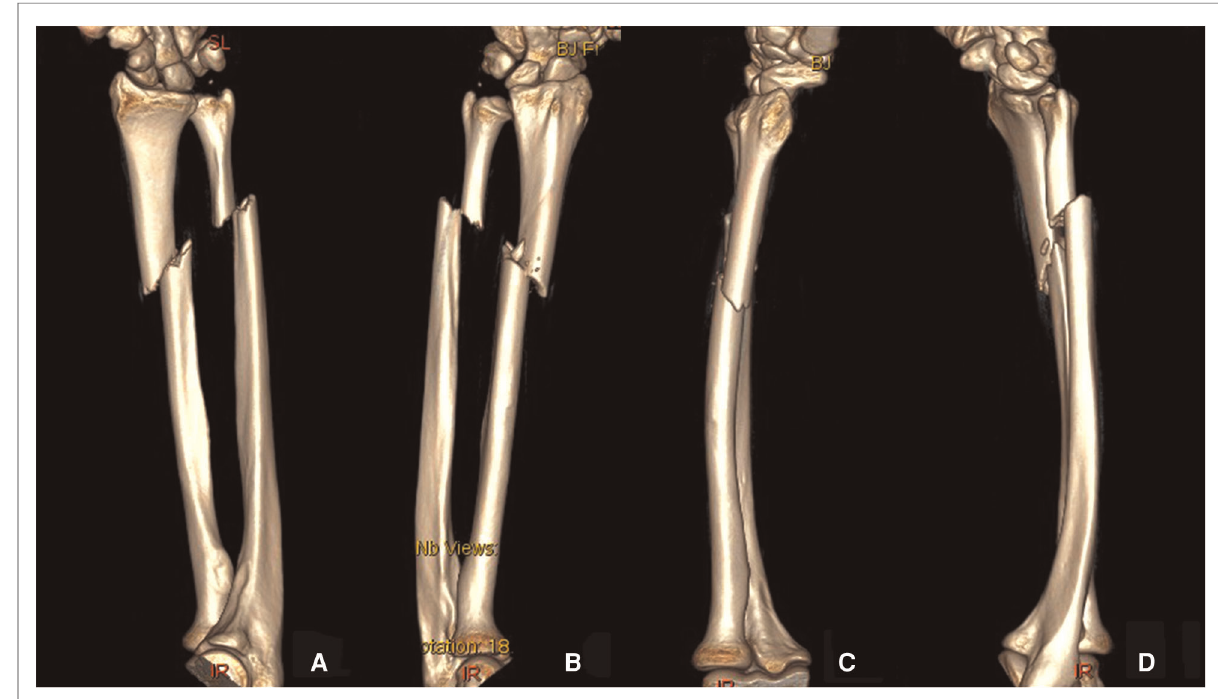
FIGURE 2 Preoperative three-dimensional reconstructive CT images ( A – D ) of the left forearm.